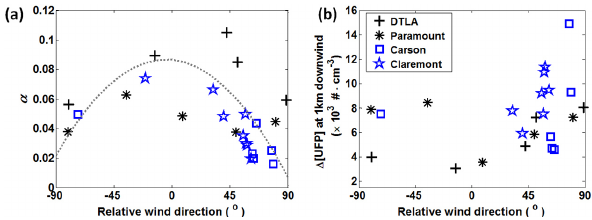
Figure 4. Wind direction effects on (a) dispersion coefficient, α , and (b) plume intensity ( 1 [UFP]) at 1km, which is defined as background-subtracted UFP concentrations at 1km downwind of freeway. Black crosses, black asterisks, blue squares, and blue stars represent daily mean values for the DTLA, Paramount, Carson, and Claremont transects, respectively. Relative wind direction is daily mean wind direction relative to freeway orientation (90 ◦ = normal to freeway). Gray dotted line in (a) represents 2nd order polynomial fits ( R 2 =